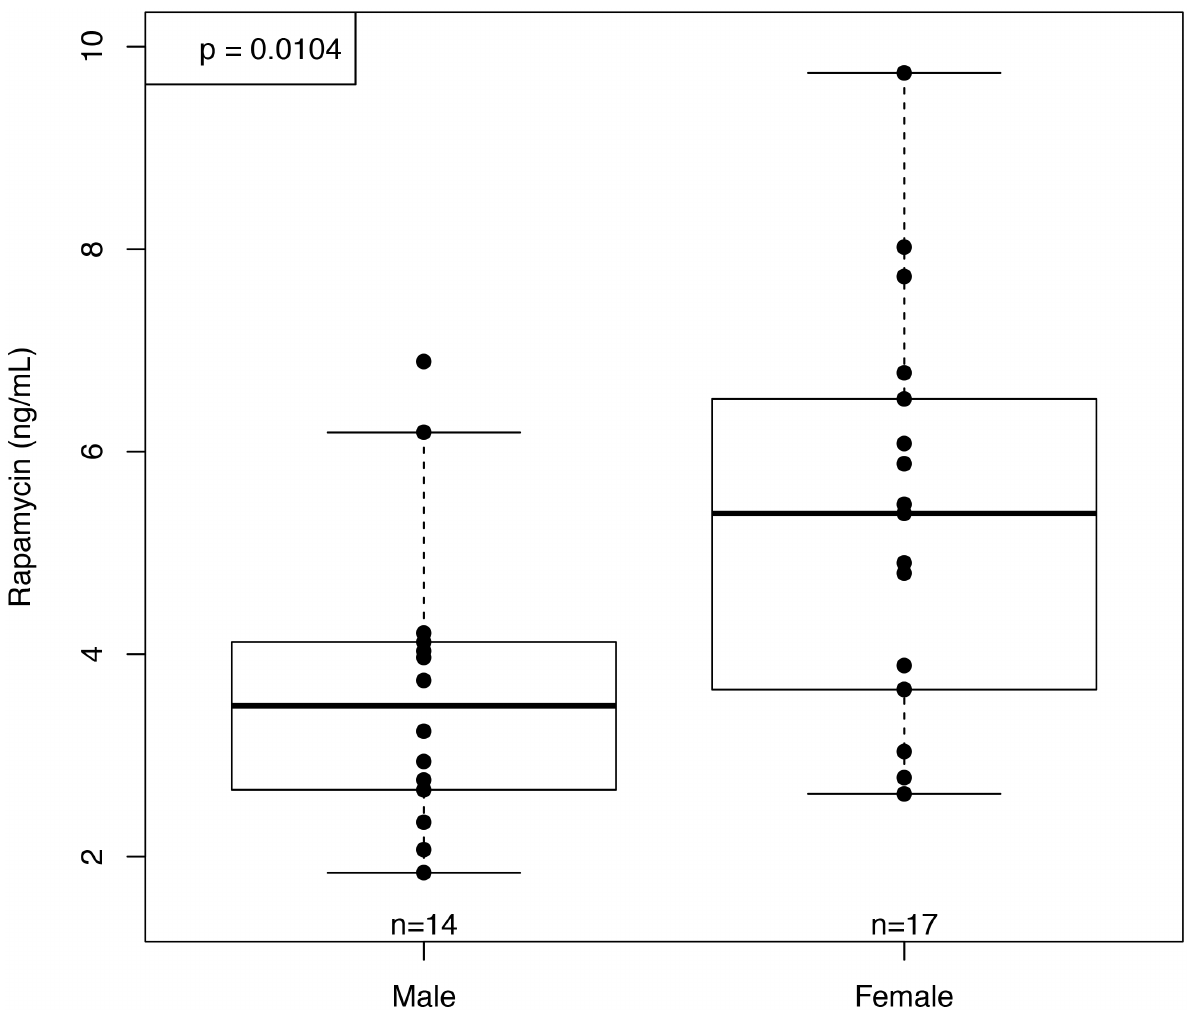
Fig 1. Rapamycin concentration in whole blood at 10 months of age (after 6 months of rapamycin feeding). Blood concentrations of rapamycin were significantly higher in females than males after 6 months of rapamycin feeding (n = 18 and 14